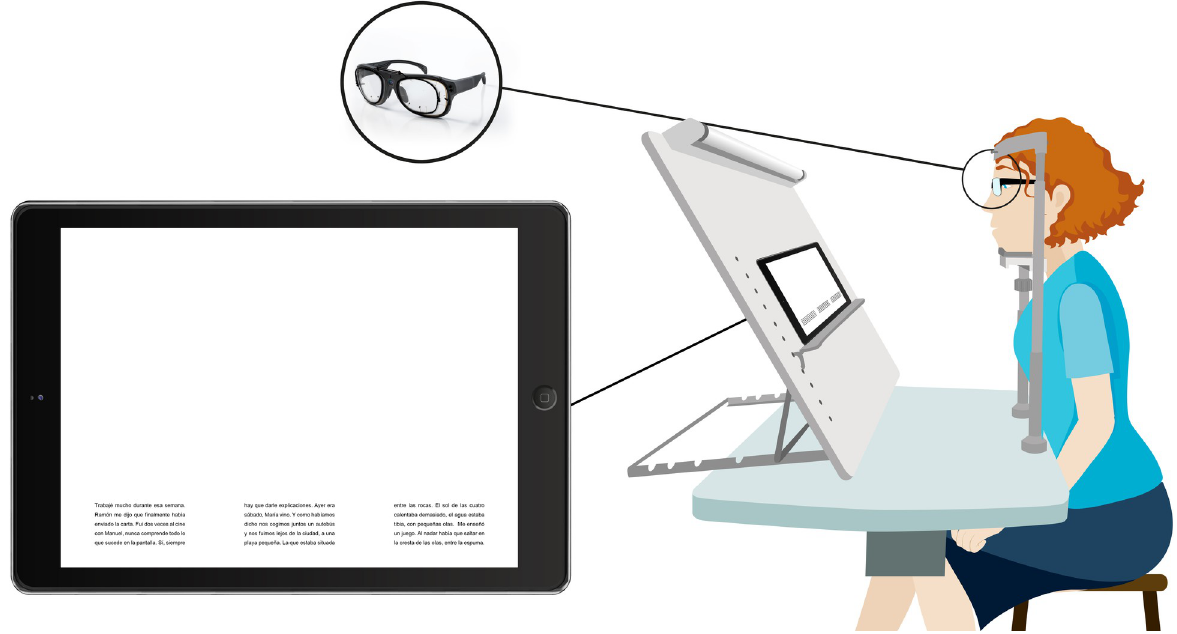
Fig 4. Scheme of the evaluation of reading performance using ET technology at near-reading